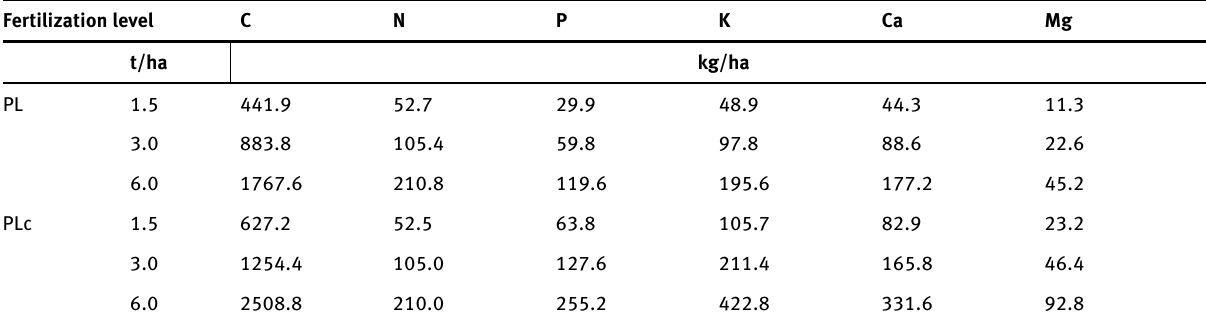
Table 3: Total elements applied into the soil Fertilization